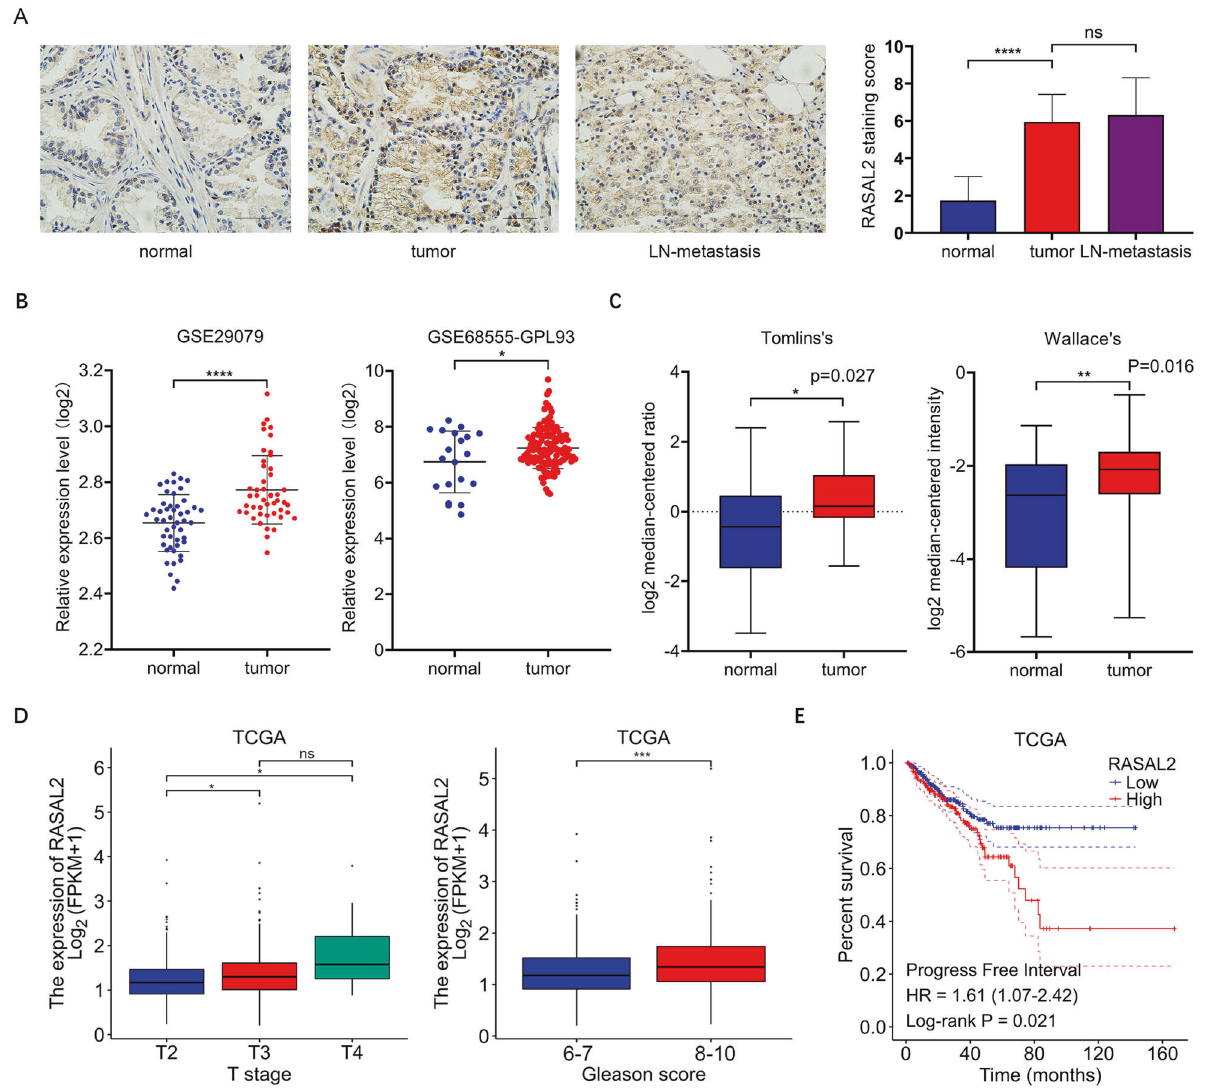
tissues from the GEO database (GSE29079 and GSE68555). C RASAL2 mRNA expression in normal prostate tissues and PCa tissues from Oncomine databases (Tomlin ’ s and Wallace ’ s). D Clinical correlation of RASAL2 with PCa T-stage and Gleason score from TCGA database. E Prognostic data for high and low expression of RASAL2 derived from the TCGA